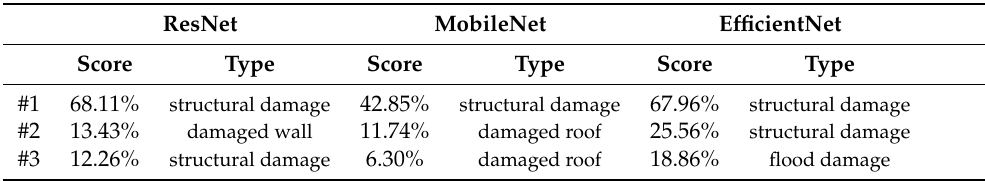
Table 7. Summary of confidence scores and associated object categories for the top three predictions made on the image of structural damage for each of the three